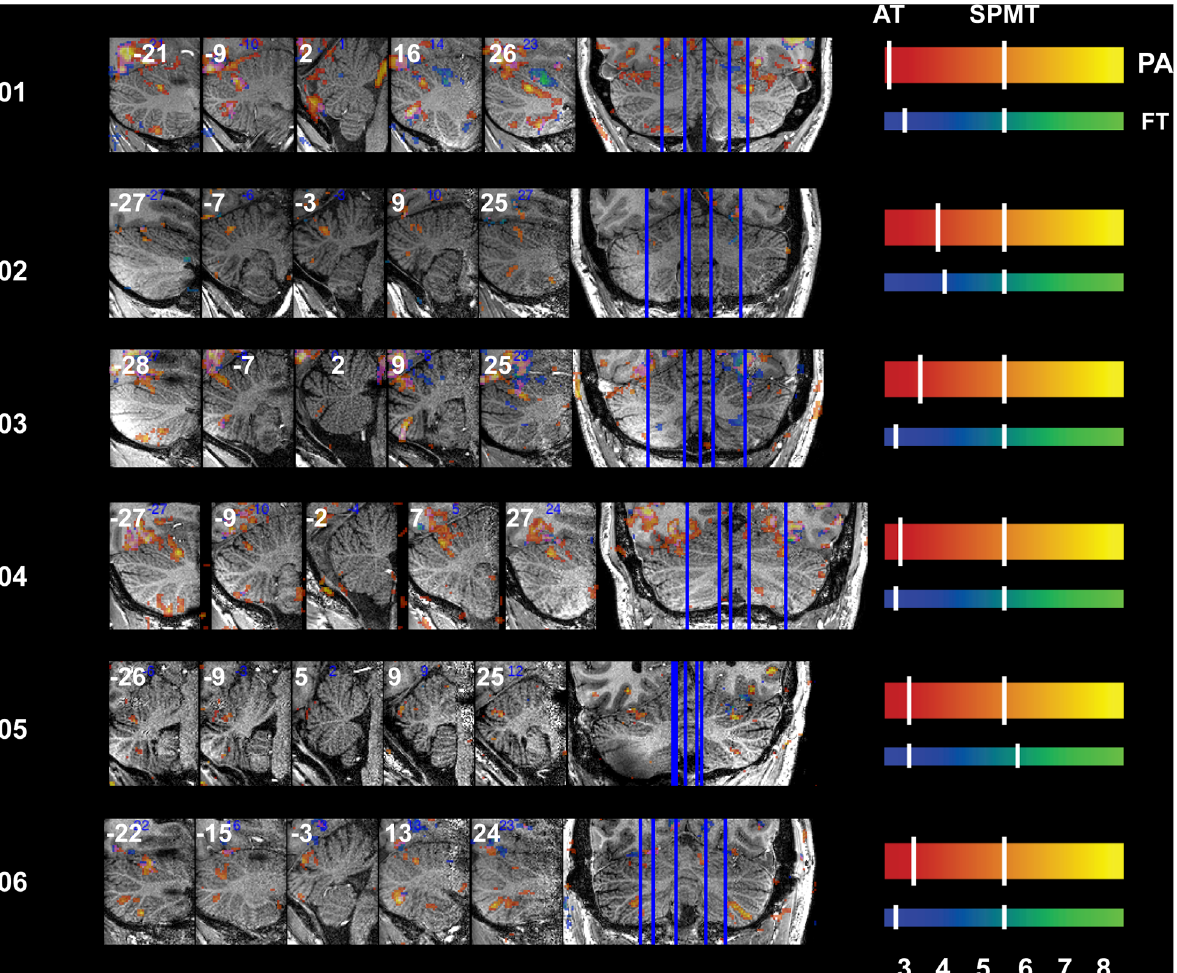
Fig 2. Functional Accuracy of Pro-Anti Activations in Cb, Oculomotor Vermis and Paravermis VI. Activity in OMV (medial posterior Cb, layers v VIc and v VII, central panel) and paravermis VI and CrusII/VIIa during the PA task is displayed on sagittal slices (vertical lines dissecting rightmost coronal view). Ventral OMV is active in all subjects besides S05 during this task while activity is also present in dorsal OMV for all subjects besides S03 and S04; slices are through Cb vermis and paravermis only. Slice locations (sagittal non-normalized MNI space, x-plane) are displayed at the top of each panel. Refer to Fig 1a for a guide to anatomical lobule